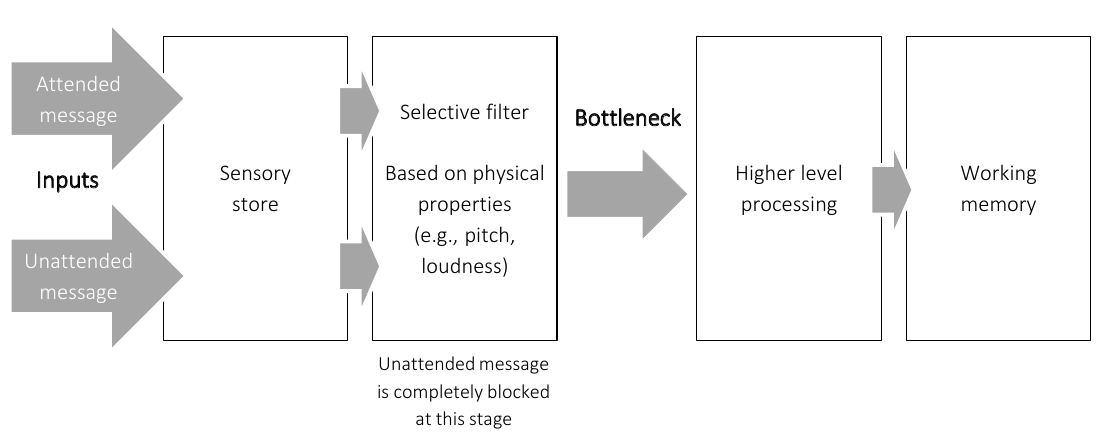
BROADBENT’S FILTER